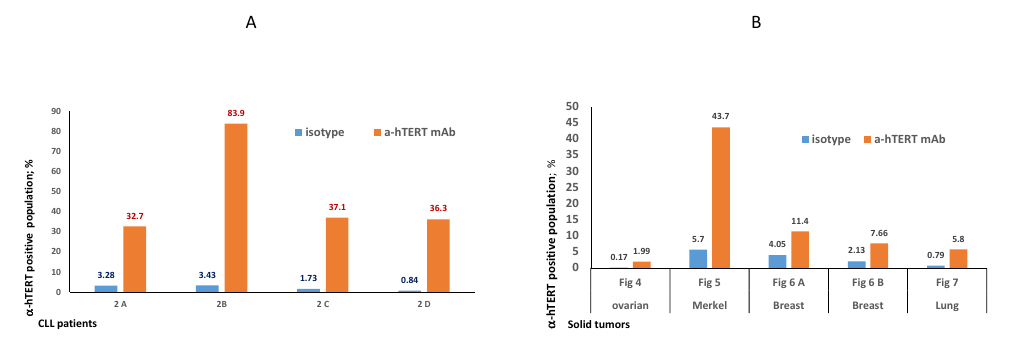
Figure 2. Ex vivo binding of the α -hTERT mAb to cancer cells obtained from patients with CLL ( A ) and from patients with solid tumors ( B ). ( A ). Binding to PBMCs from patients with CLL: 2A— a CLL patient with low amount of CLL cells (<50%), 2B—a CLL patient with high amount of CLL cells (>80%); 2C—a newly diagnosed CLL patient; 2D—a CLL patient after treatment. ( B ). Binding to circulating neoplastic cells and tumor cells suspension from patients with solid tumors as depicted in the X axis. The relevant dot plots are provided in the corresponding Supplementary Materials Figures (Figures S1–S4).